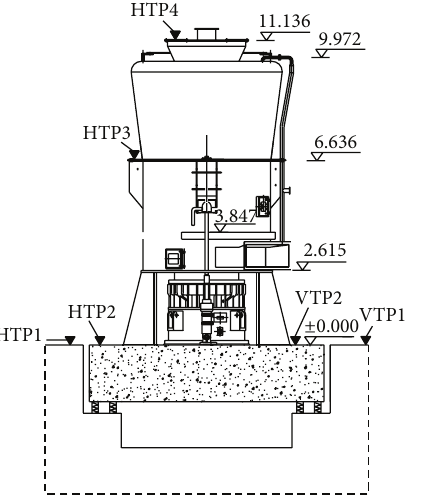
Figure 7: Placement of sensors (HTTP:horizontal test point, VTP: vertical test point).